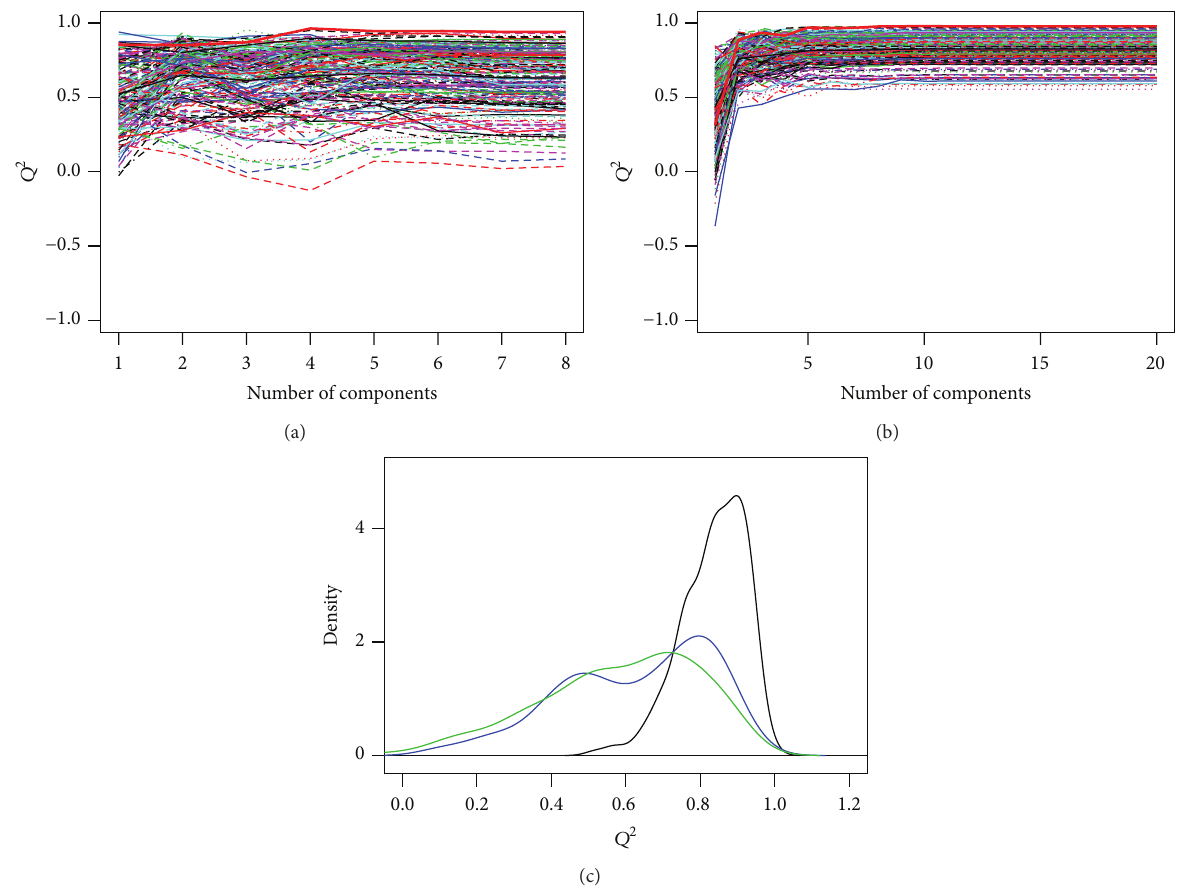
Figure 3: (a) and (b) show the behavior of 𝑄 2 as a function of the number of latent vectors (LVs) for 100 models sampled randomly for GC-MS (7 predictors, (c)) and NMR (1610 predictors, (b)). The thick red curve represents the average of all models and its turning point is used to determine the best number of components for which the distributions are shown on (c). The green curve represents the distribution of 𝑄 2 for 2 LVs (GC-MS). The blue and black curves are for NMR using 2 and 8 LVs, respectively, and using either all the predictors (black) or only the best 8 predictors (blue), selected according to their